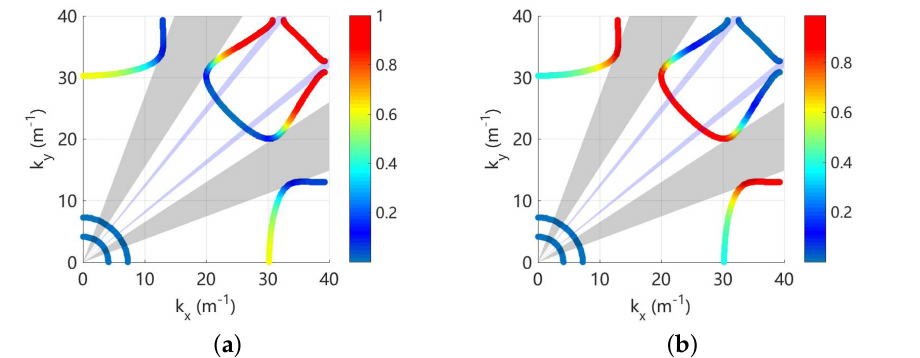
Figure 10. Wavenumber of the propagation waves at 1400 Hz for L-network with L = 0.1 H: ( a ) coloured by RSW f and ( b ) coloured by RSW e . The grey and purple areas indicate the coupled and Bragg gaps